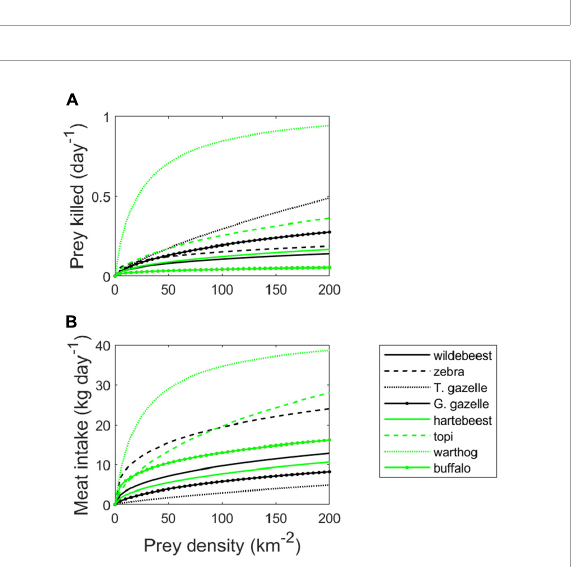
FIGURE4 Group-dependent lion functional response for eight species of large herbivore prey in Serengeti (A) and the rate of meat intake as a result of this response (B) . Parameters given in Table 1 .